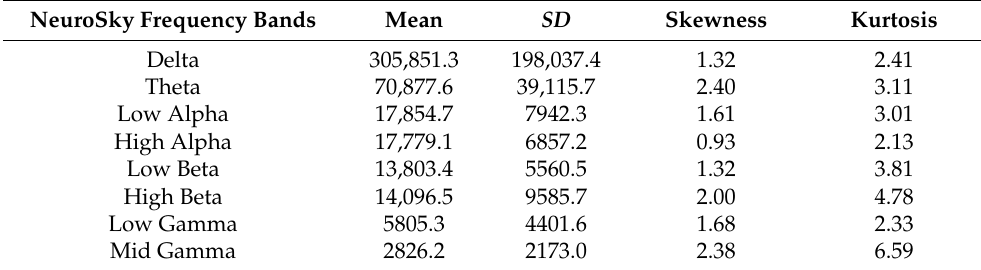
Table 3. Descriptive statistics of the neurophysiological variables during ASMR video. Brain wave values are measured in